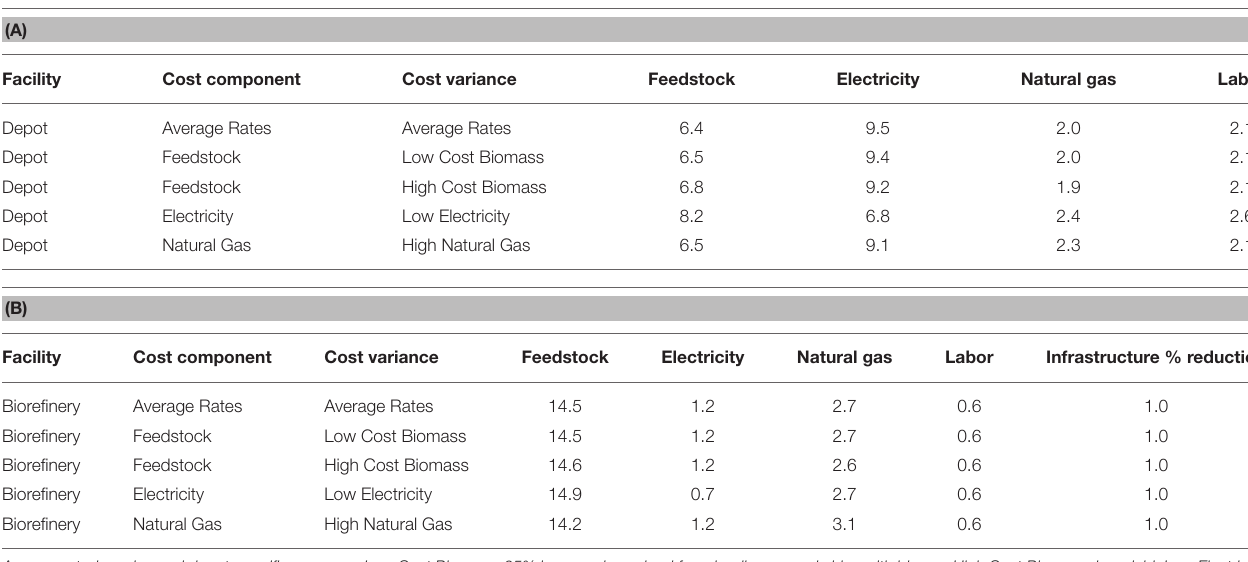
TABLE 9 | Weighting sensitivity analysis for (A) depot and (B) biorefinery decision matrices.